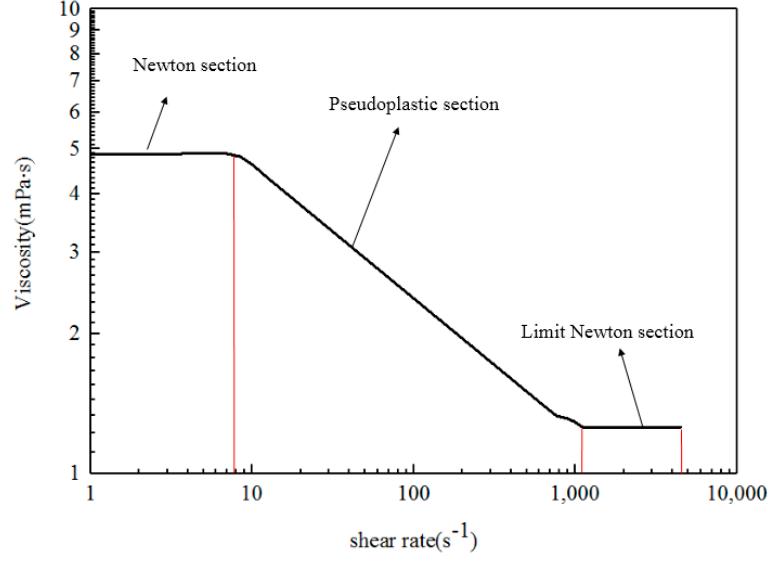
Figure 3. Rheological curve.